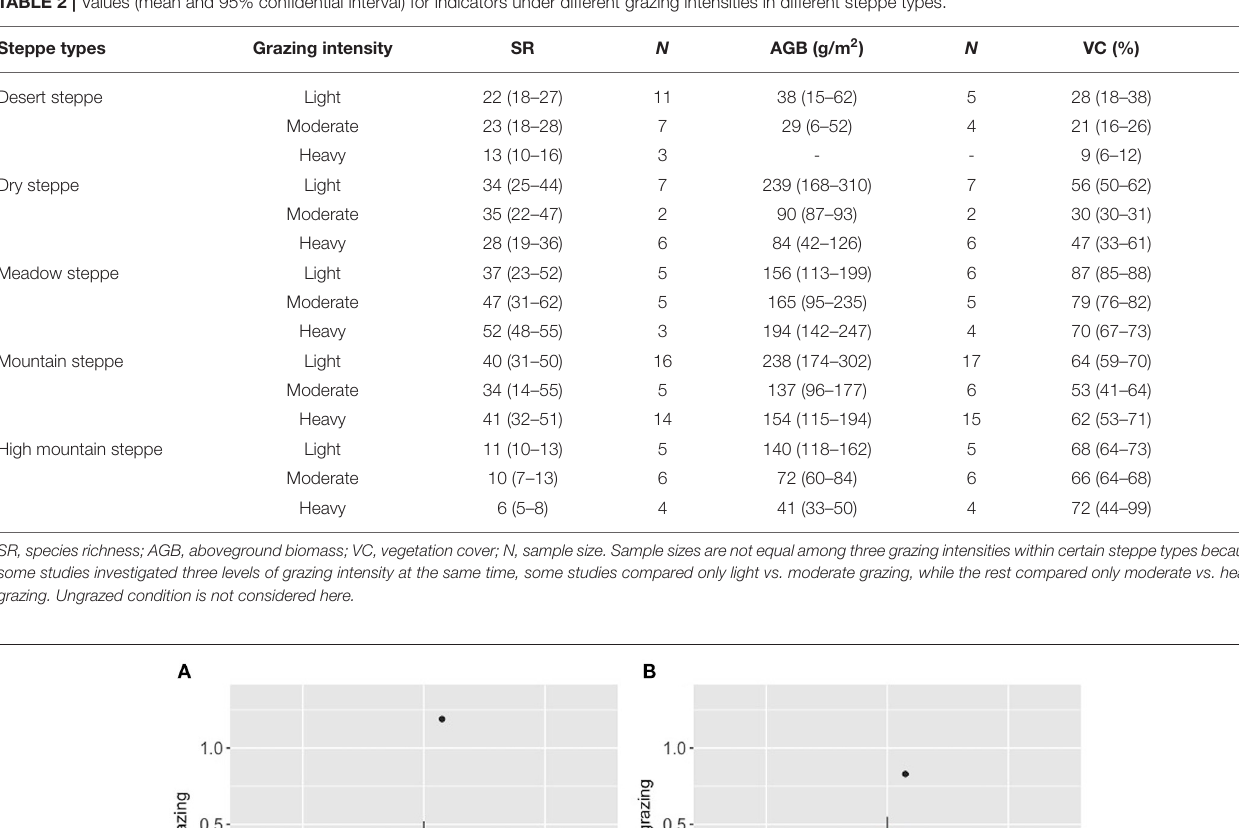
TABLE 2 | Values (mean and 95% confidential interval) for indicators under different grazing intensities in different steppe types. Steppe types Grazing intensity